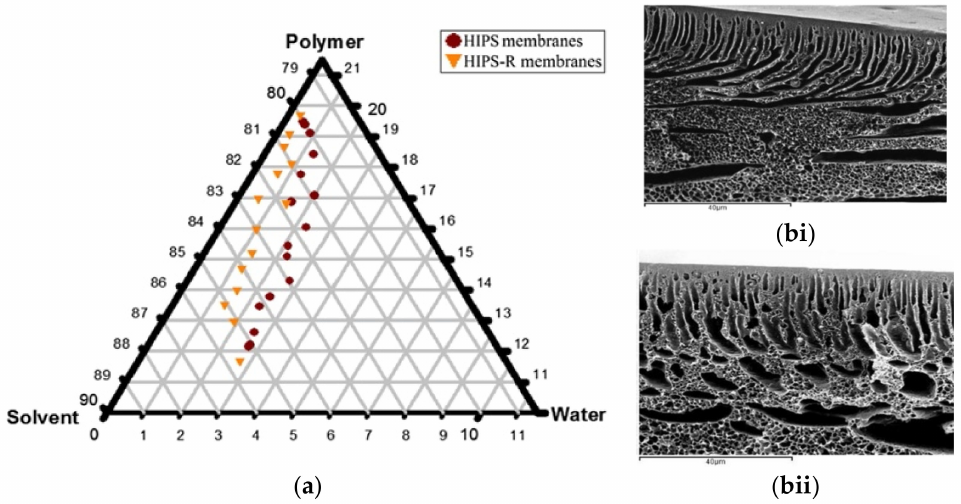
Figure 6. ( a ) Ternary phase diagram constructed based on cloud point measurements with commercial HIPS and recycled HIPS as base polymer and DMF as a solvent. ( b ) Cross-sectional images of membranes formed from (i) commercial HIPS and (ii) recycled HIPS